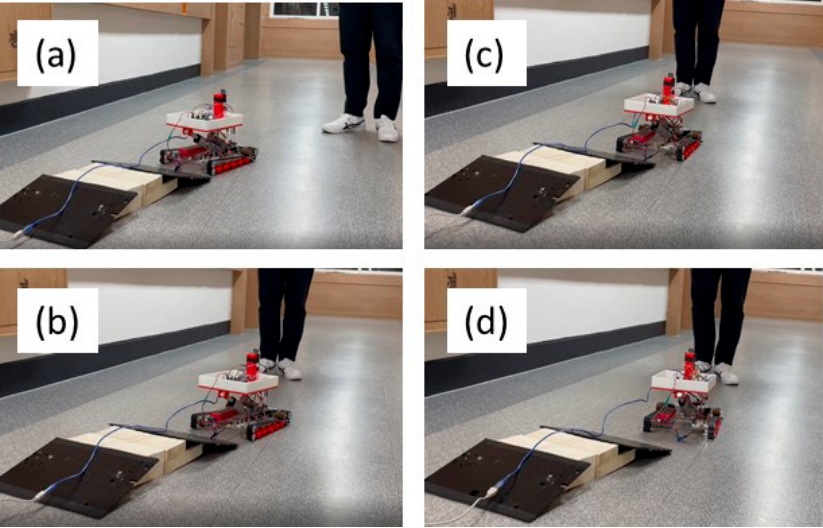
Figure 18. Video clip capture images during the experiments; Case II: clip order: ( a – d ).